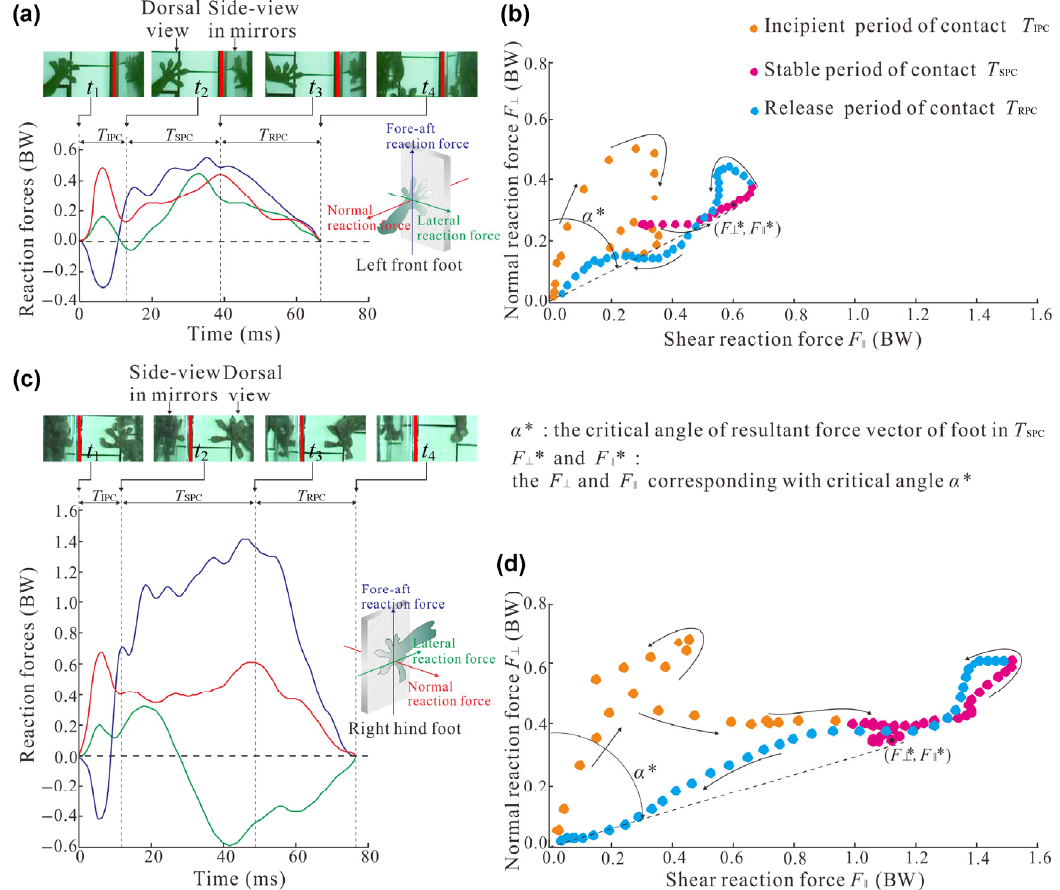
Fig. 2 State and reaction forces of feet of a freely climbing Gekko gecko. (a) The relationship between the state and reaction forces acting on the right front foot. (b) The normal reaction force ( F ⊥ ) vs. shear reaction force ( F || ) acting on the left front foot. The force data for different periods of contact is indicated by different colors. We examined the data shown in pink ( T SPC ) to investigate the effect of synergy between the friction and adhesion, or adhesion and adhesion on the reliability of the contact. (c) The relationship between the state and the reaction forces acting on the left hind foot. (d) The normal reaction force ( F ⊥ ) vs. shear reaction force ( F || ) acting on the left hind